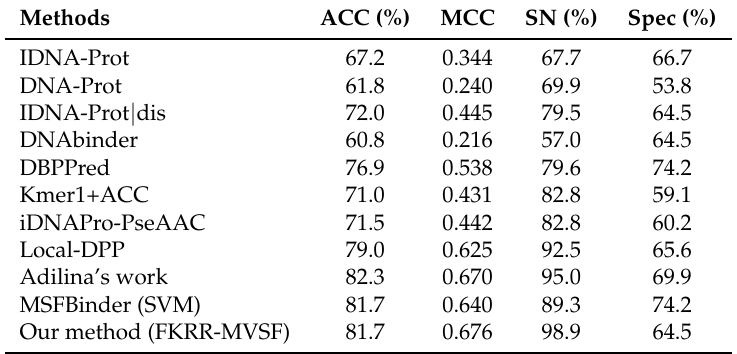
Table 4. Compared with existing methods on the PDB186 dataset (Independent test).